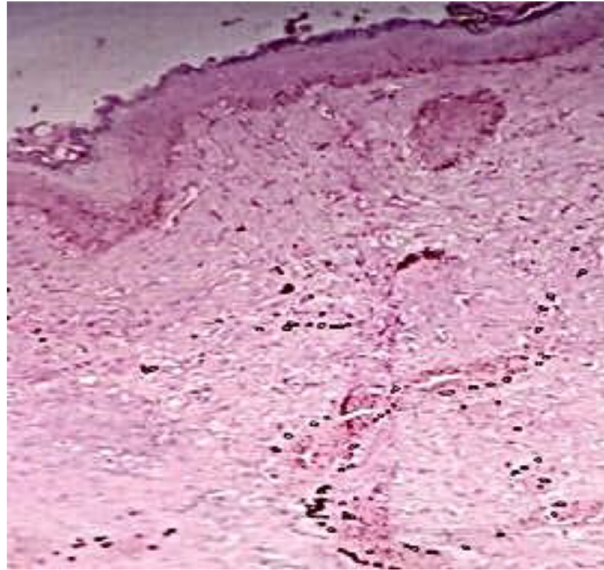
Fig. 5. Photomicrograph of mucosal section inked with nail enamel showing penetration into deeper connective tissue.